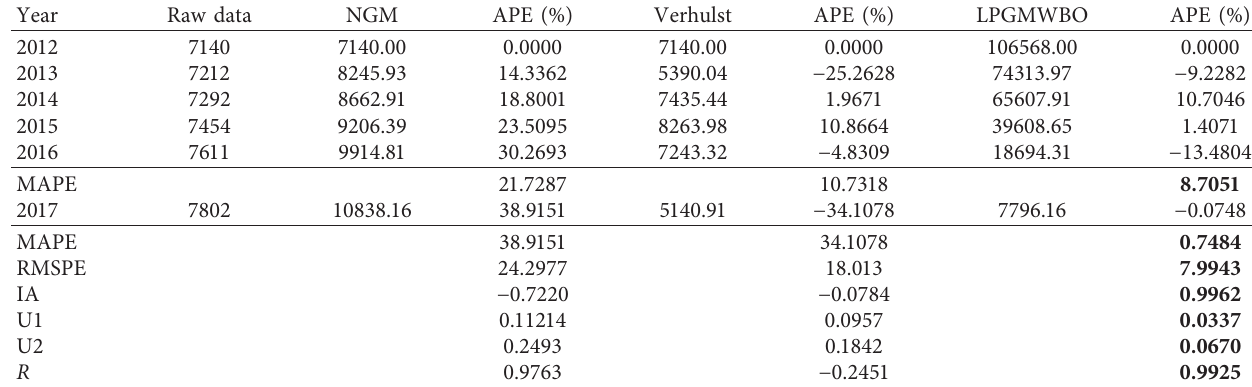
Table 8: Fitting metrics of models for validation of Guangdong data.